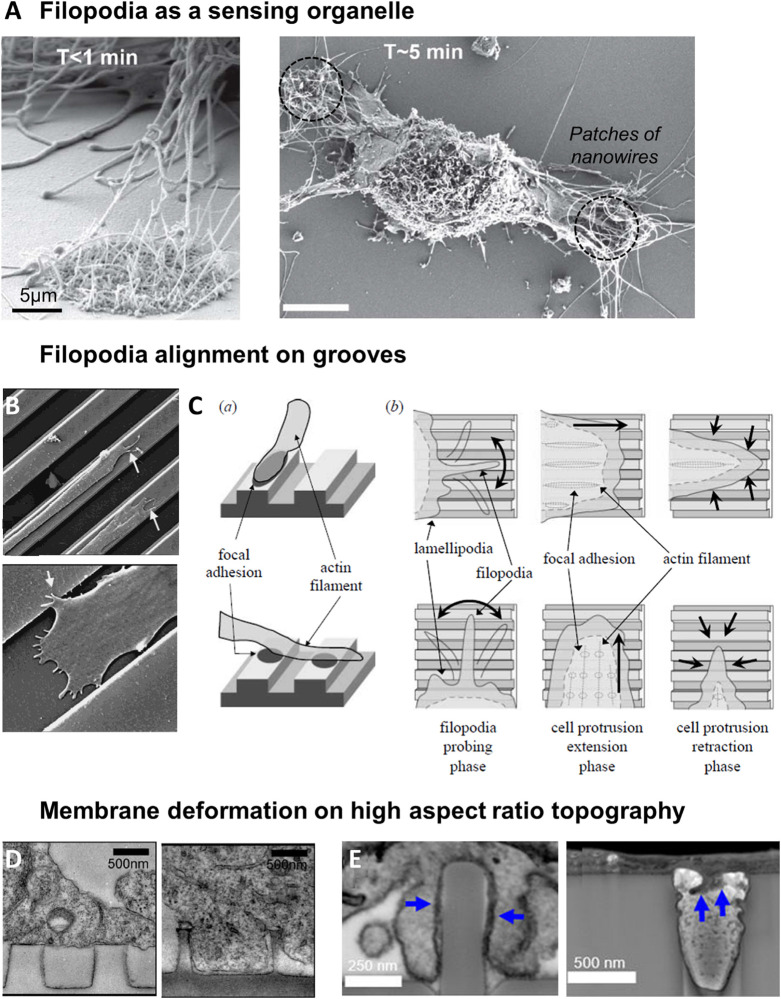
Filopodia as a sensor of topography. (A) Sensing of nanowires by filopodia of fibroblasts. Shortly after plating, filopodia explore both flat and nantopography (left). After 5 min, filopodia on flat surface have retracted (right). From Albuschies and Vogel (2013). (B) SEM image of epithelial cell sending filopodia along ridges and grooves. Reproduced with permission from Dalton et al. (2001). (C) Model of cell alignment on grooves by filopodia probing and perpendicular filopodia retraction. Reproduced with permission from Fujita et al. (2009). (D) Membrane deformation of cortical neurons on nanopillars seen by TEM. On pillars of 500 nm diameter, 1 μm spacing, cell body rests on top of the pillars (left). On 200 nm diameter pillars with the same center-to-center distance, membrane deforms to engulf the pillars (right). Reproduced with permission from Hanson et al. (2012). Copyright 2012 American Chemical Society. (E) FIB SEM cross sections reveal that plasma membrane wraps tightly around nanopillars with 400 nm diameter (left), but hardly deforms into 400 nm diameter nanopores (right, blue arrows). Reproduced with permission from Santoro et al. (2017). Copyright 2017 American Chemical Society.